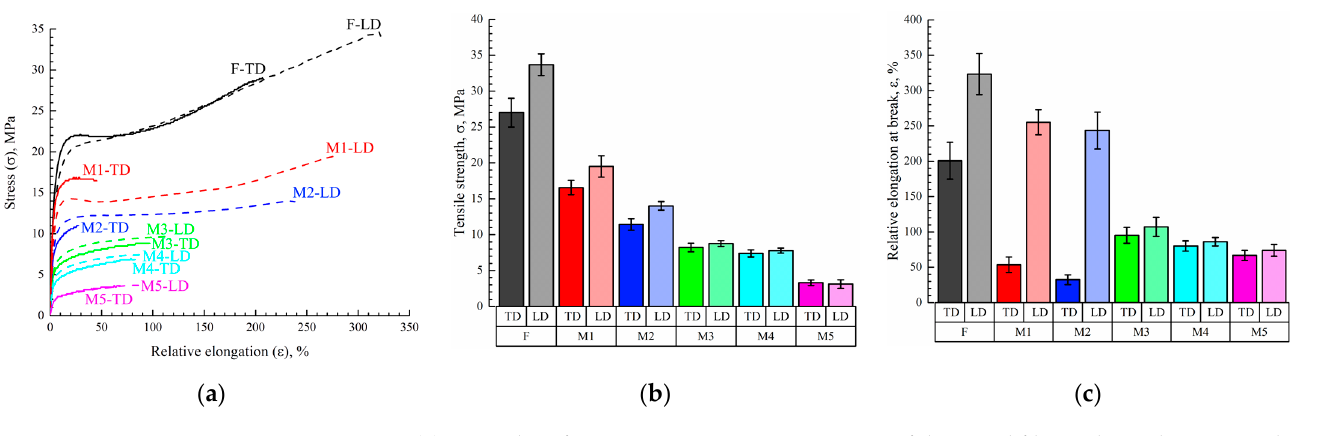
Figure 6. ( a ) Examples of engineering stress-strain curves of the initial film and membrane samples both in longitudinal (LD, dashed curves) and transverse (TD, solid curves) directions and mean values of ( b ) tensile strength and ( c ) relative elongation at break of these samples.